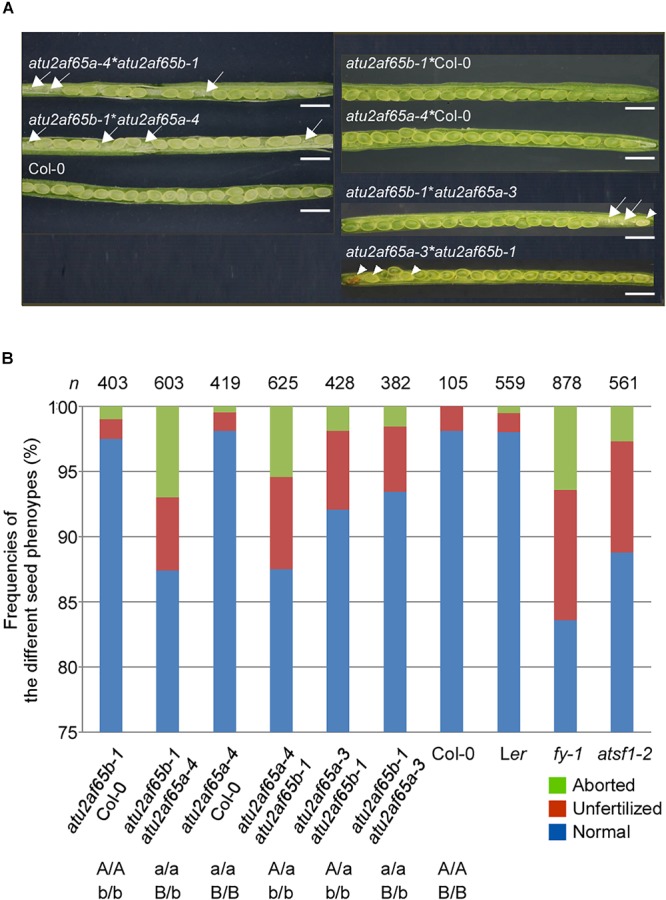
Seed developmental defects in siliques of various combinations of atu2af65a and atu2af65b mutants. (A) Seed phenotype of dissected siliques from various atu2af65a atu2af65b heterozygous double mutants in the F2 progeny. The plants obtained from the crosses between atu2af65a-4 or atu2af65a-3, and atu2af65b-1 single mutants as male parents and wild-type plants as female parents were used as controls. The arrows and arrow heads indicate the unfertilized ovules and aborted seeds, respectively. The classification of seed phenotypes in siliques has been described previously (Zhou et al., 2013). Scale bars 1.5 mm. (B) A histogram showing the fractions of normal and aborted seeds, and unfertilized ovules from various atu2af65a atu2af65b heterozygous double mutants in the F3 progeny. The genotypes of F3 progenies are indicated below the histogram. Other splicing factor mutants such as fy-1 and atsf1-2 were used to compare the seed developmental defects of atu2af65a atu2af65b heterozygous double mutants. Ler and Col-0 plants were used as controls for fy-1 mutants and other plants. n denotes the numbers of siliques used for the analysis of seed phenotype.